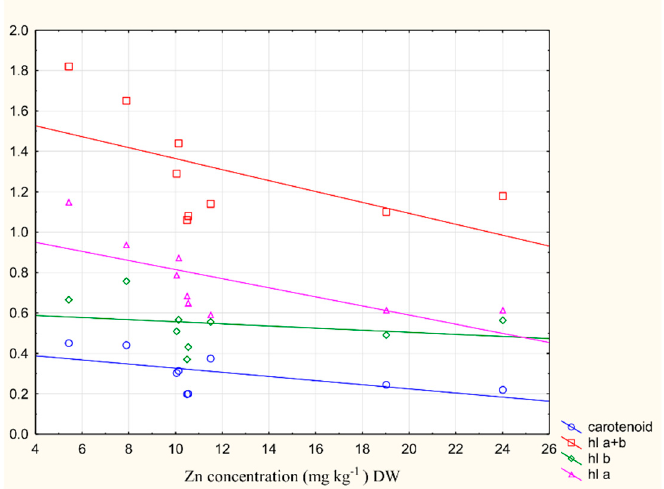
Figure 7. The values of the Pearson’s correlation coefficient ( p < 0.05) between the pigment content and the Zn concentration in the leaf of Trapa natans L. r = − 0.68, p < 0.05.